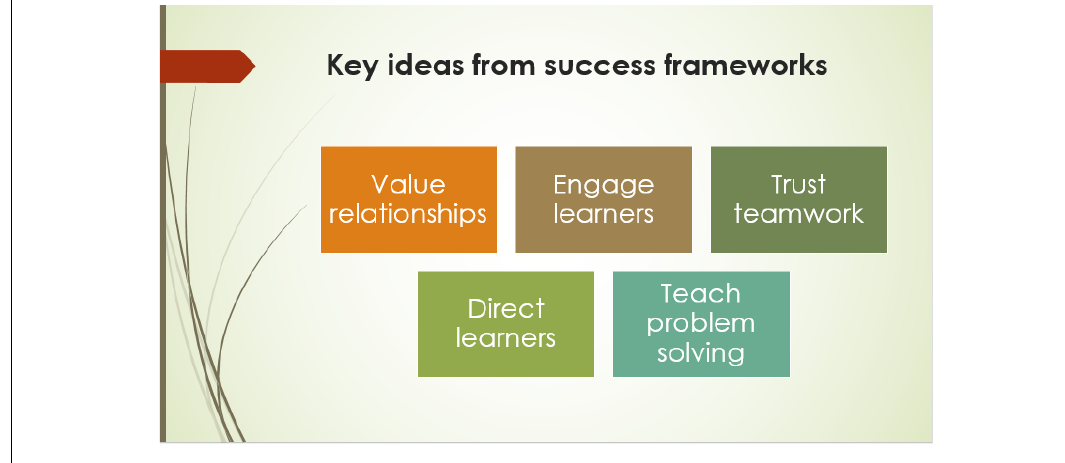
Figure 1: Key ideas from success